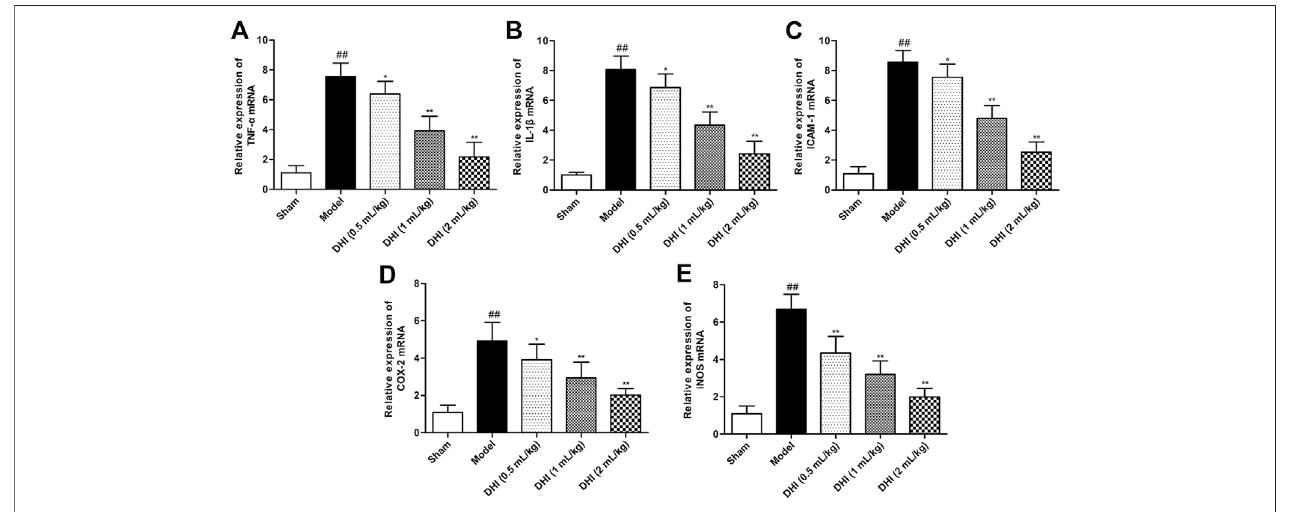
FIGURE 5 | Effects of DHI on the levels of in fl ammatory cytokines in serum and MPO activity of ischemic brains in rats after CIRI. (A) TNF- α , (B) IL-1 β , (C) MCP-1, and (D) MPO. Mean ± SD ( n (cid:2) 6). Asterisks denote the signi fi cant levels: ## P < 0.01 vs. sham group and * P < 0.05 and ** P < 0.01 vs. model group.